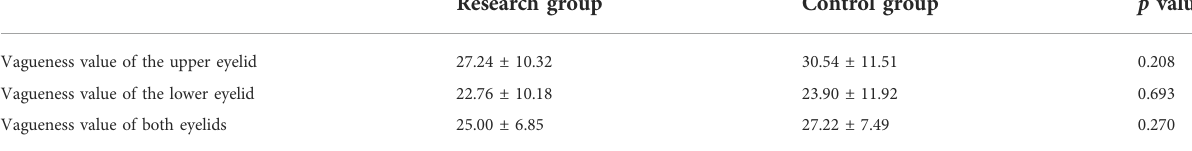
TABLE 2 MG vagueness value in the research group and normal control